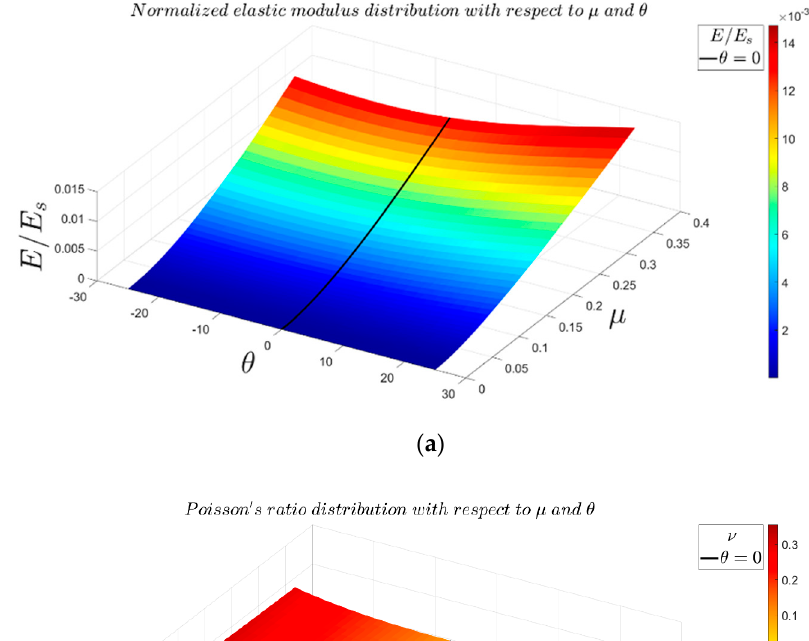
Figure 15. Generic geometry of the unit cell with positive (top), zero (middle), and negative (bottom) values of 𝜃 and 𝜑 for general unit cell (left column) and lightened unit cell (right column): ( a ) gen- eral re-entrant; ( b ) lightened re-entrant; ( c ) general zero Poisson’s ratio; ( d ) lightened zero Poisson’s ratio; ( e ) general convex; and ( f ) lightened convex unit cells.